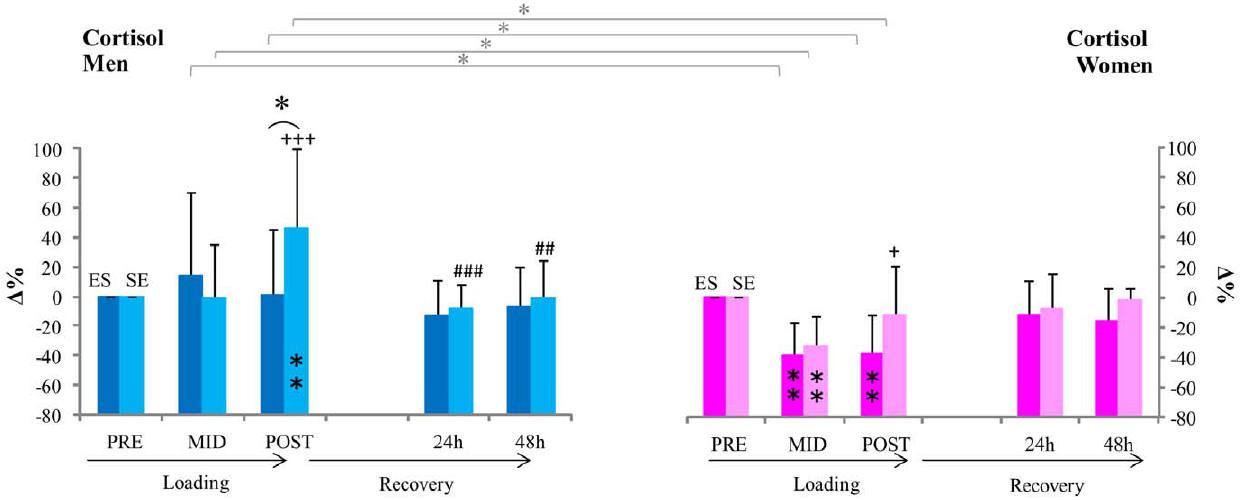
Figure 4. Serum cortisol. ** inside column=significant change (p , 0.01) from pre in absolute serum cortisol concentrations, +++ =significant change (p , 0.001) in absolute serum cortisol from mid. *[=significant difference (p , 0.05) between relative changes in serum cortisol concentrations from pre in men and women, *(=p , 0.05 significant differences between relative changes from pre in ES and SE loadings.